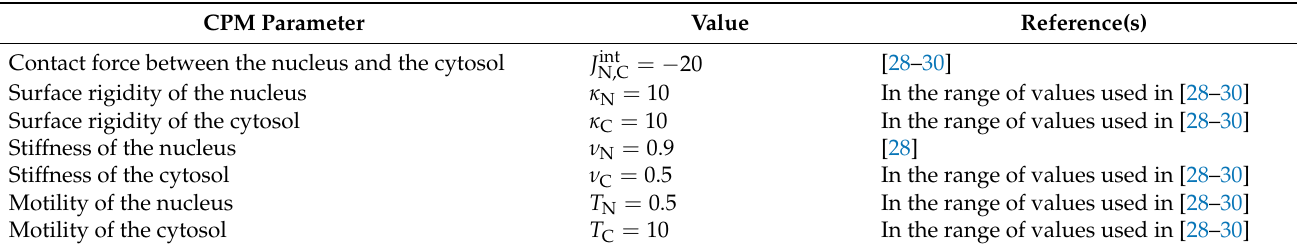
Table 1. Values of the Cellular Potts model (CPM) technical parameters, i.e., those included in the set P 2 (see Equation (11)), which were used for both experimental